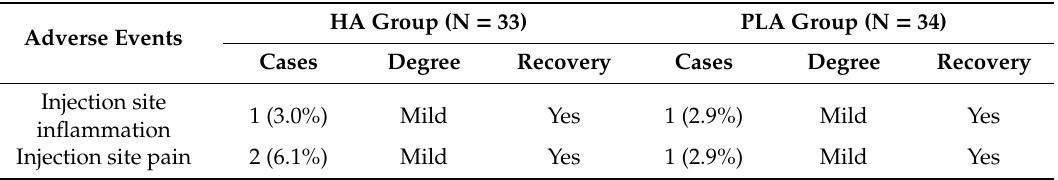
Table 2. Filler injection-related adverse